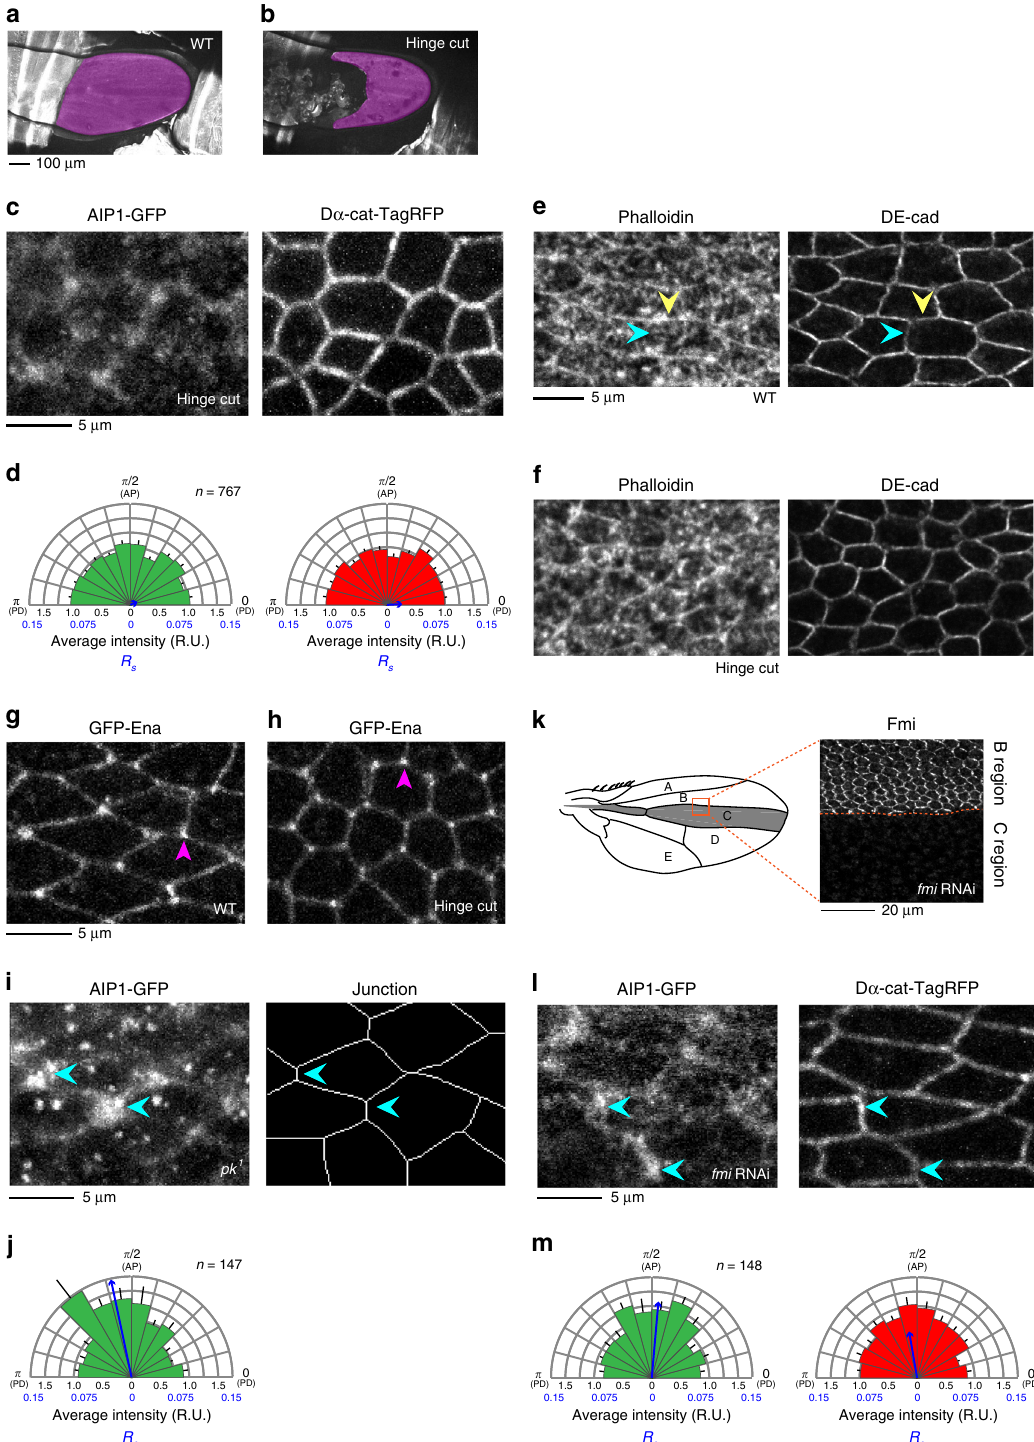
cells, in which GFP-tagged endogenous co fi lin fl uorescence was not detected (Supplementary Figure 2j), AIP1 was diffusely distributed in the AJ plane, with little accumulation at the AJ plane along the apico-basal axis (Supplementary Figure 3b-e). fl r dsRNA-expressing cells exhibited abnormal aggregates of co fi lin in the cytosol (Supplementary Figure. 3f-k). The enrichment of co fi lin at the junction is more evident along the plane of AJ, presumably because co fi lin remained in actin cables along the